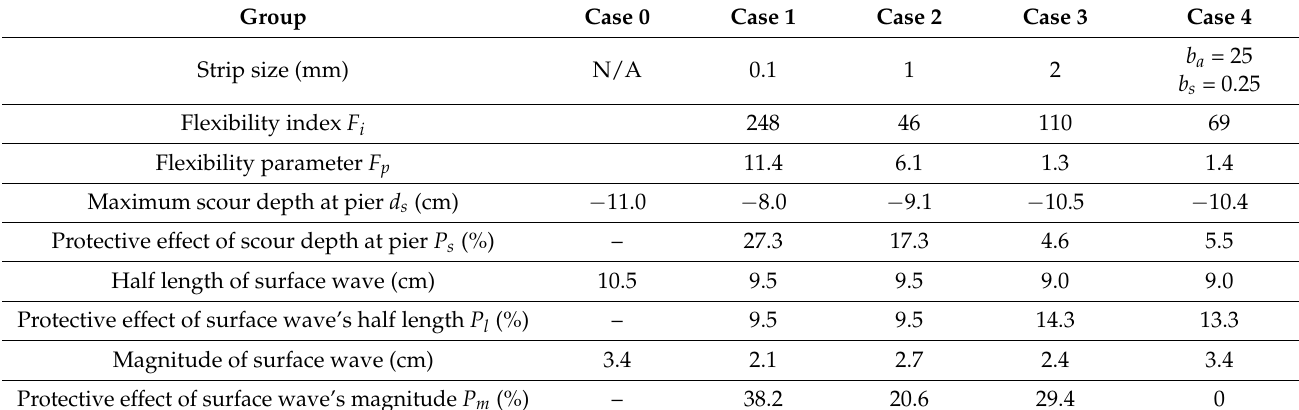
Table 4. Protective effect with different size of strips.